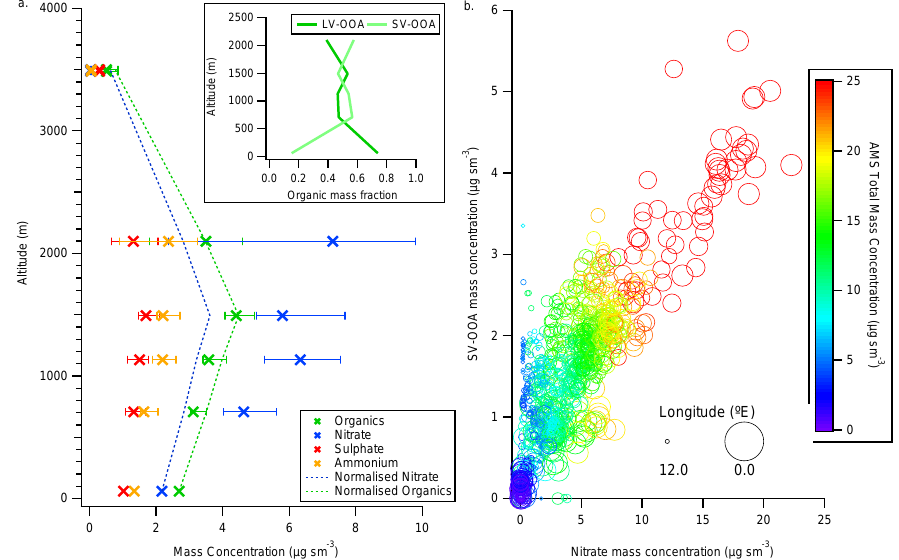
Fig. 6. Case study example of the vertical distribution of aerosol chemical composition. Panel (a) displays the AMS mass concentrations as a function of height from SLRs in the vicinity of Cabauw during flight B366, where the markers indicate the median concentration and the horizontal bars represent the 25th and 75th percentiles. The points at the lowest altitude correspond to the concentrations from a ground- based AMS at Cabauw. The hashed lines represent the normalised nitrate and organic profiles when they are scaled to the change in sulphate with height relative to the ground-based measurement. The inset panel displays the altitude dependence of the Low-Volatility Oxygenated Organic Aerosol (LV-OOA) and the Semi-Volatile Oxygenated Organic Aerosol (SV-OOA) organic mass fractions. Panel (b) displays the relationship between the SV-OOA component and nitrate for B362, B366 and B379. The markers are coloured according to the AMS total mass concentration and sized by